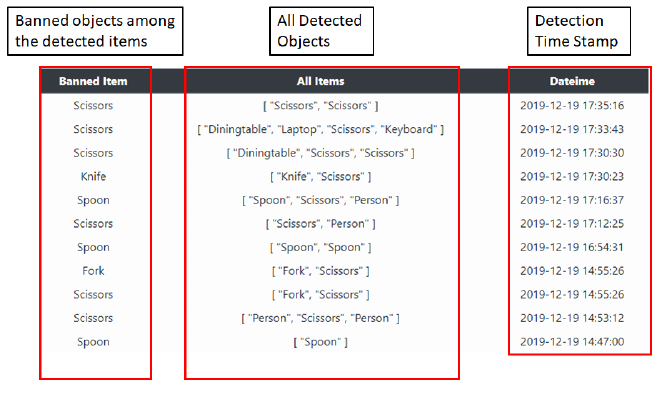
Figure 8. Detected objects log